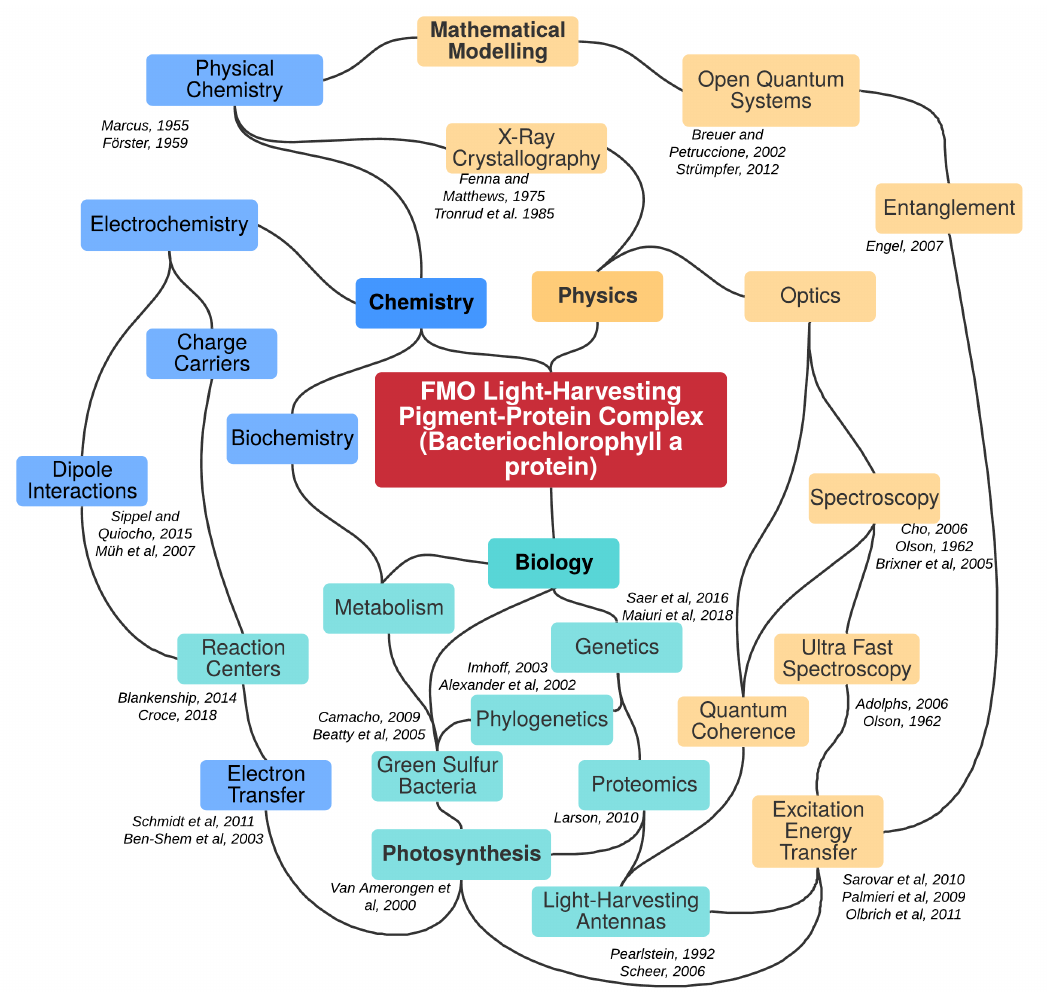
Figure 1. Schematic map of the multidisciplinary study surrounding the FMO research and some works that have provided the basis of this